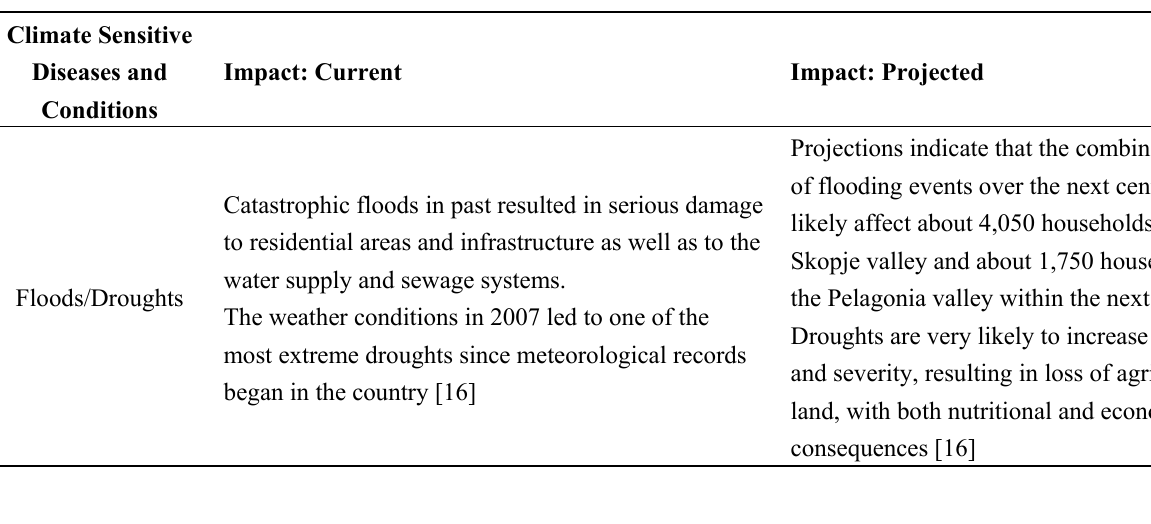
Table 3. Results from (h)